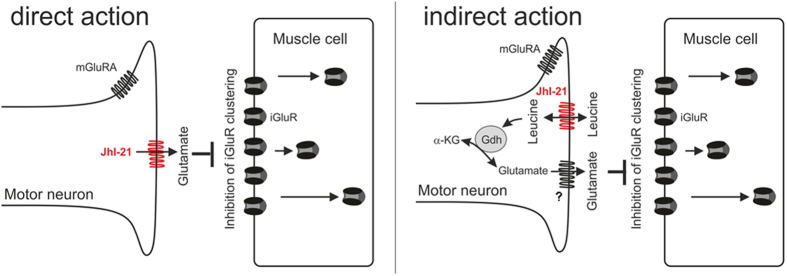
JhI-21 co-evolved with glutamate receptors, and regulates strength of glutamatergic signaling at the larval NMJ.JhI-21 is expressed in motor neurons together with mGluRA, and regulates synaptic strength by inhibiting the clustering of iGluRs at the postsynaptic muscle cell specifically during the wandering stage in third-instar larvae. The schematic representation illustrates two possible functions of JhI-21 on iGluR clustering in wandering larvae. On the left is shown the direct export of glutamate close to the synapse, which inhibits iGluR clustering. On the right, an indirect action of JhI-21 is proposed through the transport of leucine. Leucine acts on the activity of the Glutamate dehydrogenase (Gdh), which can reciprocally catalyze the production of a-ketoglutarate (a-KG) to glutamate within the motoneuron. Glutamate then could be released to the hemolymph surrounding the NMJ via an unidentified transporter, and act on iGluR clustering.